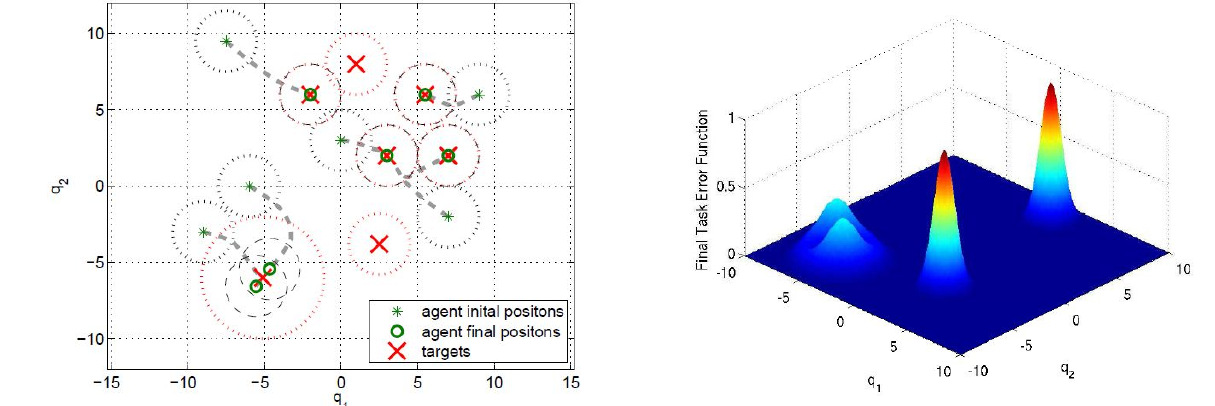
Figure 6. Switching controller performance (Example 2).